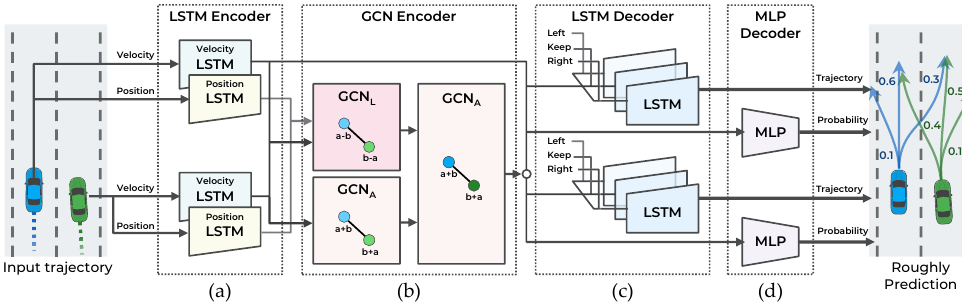
Figure 3. Illustration of maneuver-based multimodal trajectory prediction network with four compo- nents: ( a ) LSTM encoder, ( b ) GCN encoder, ( c ) LSTM decoder, and ( d ) MLP